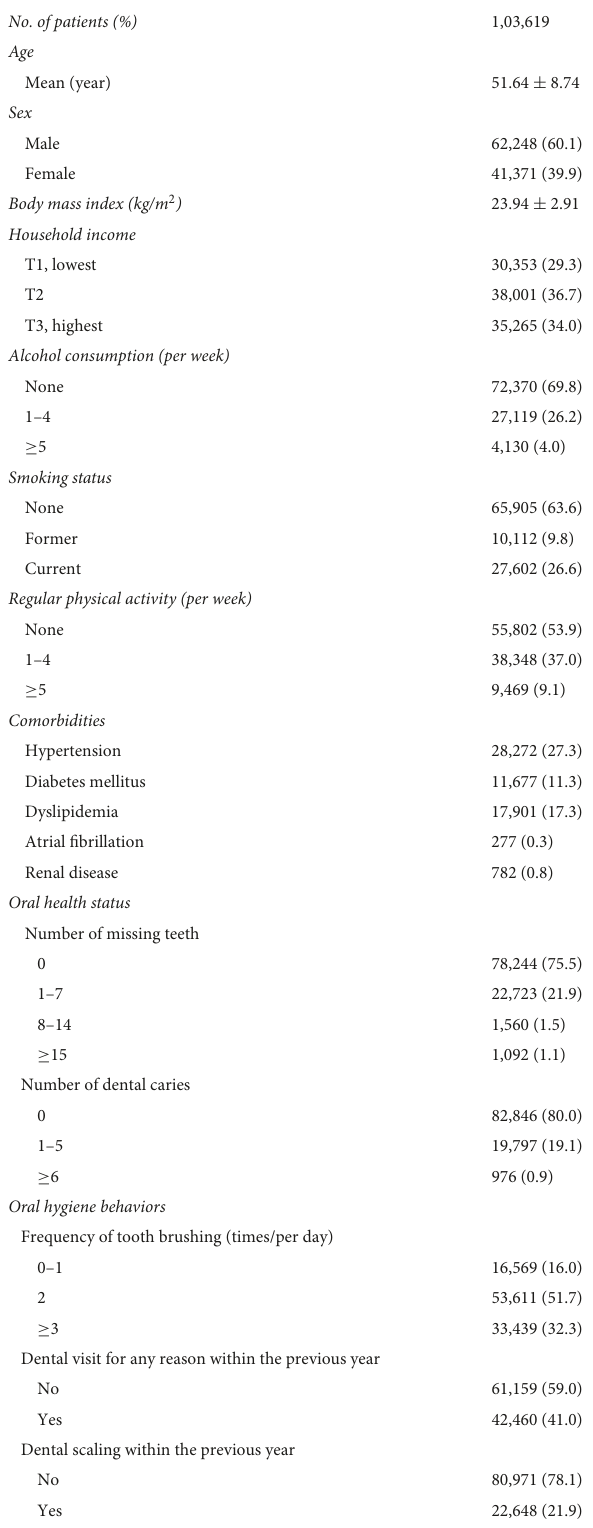
TABLE 1 Baseline characteristics of the study